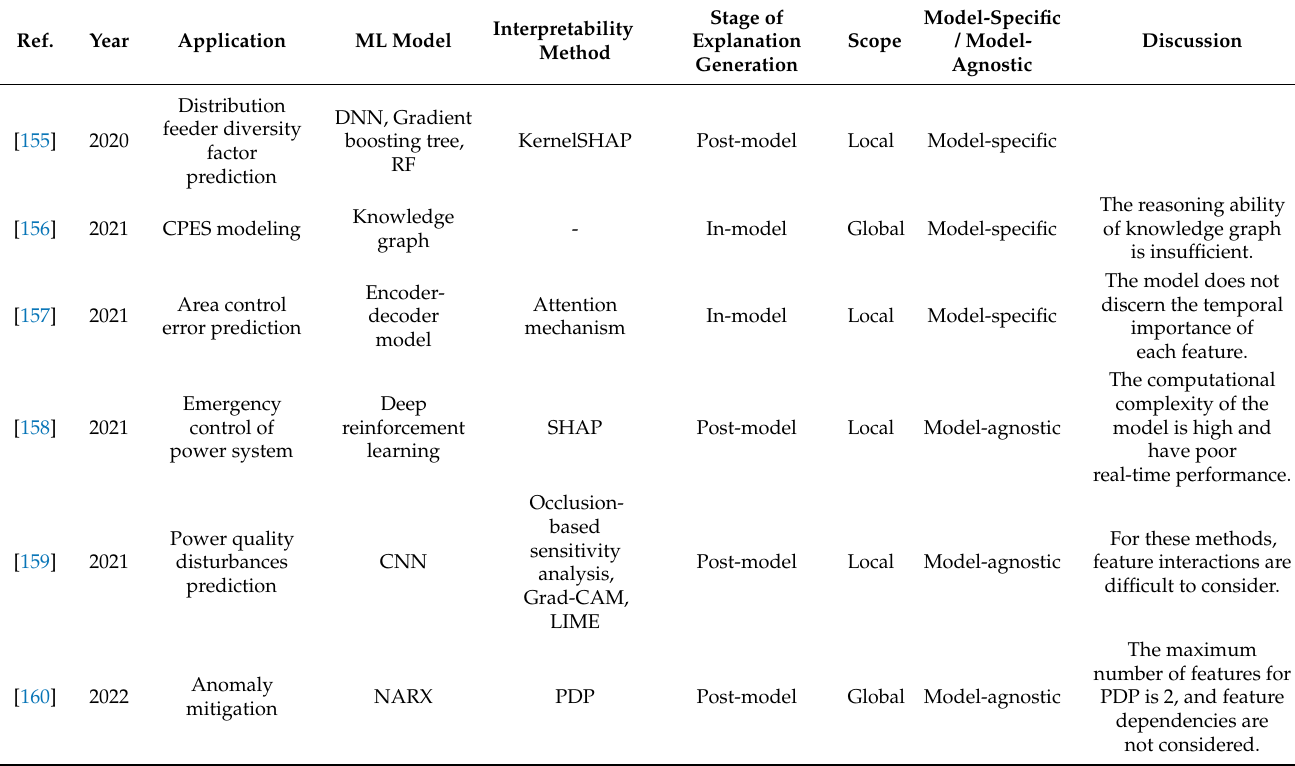
Table 6. Summary of interpretable ML for other smart grid